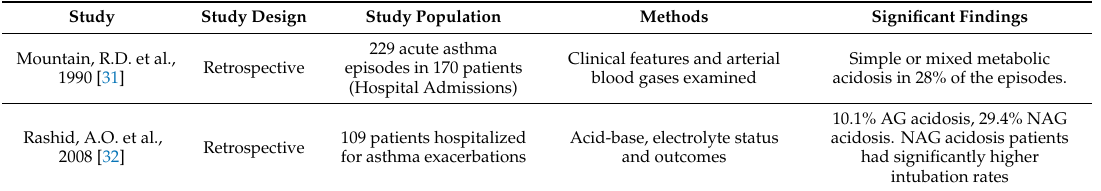
Table 3. Metabolic